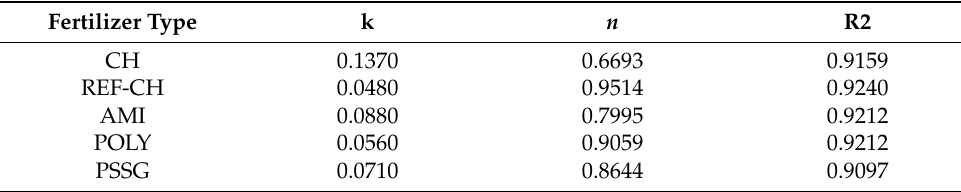
Table 4. Kinetic parameters values for compounds release *